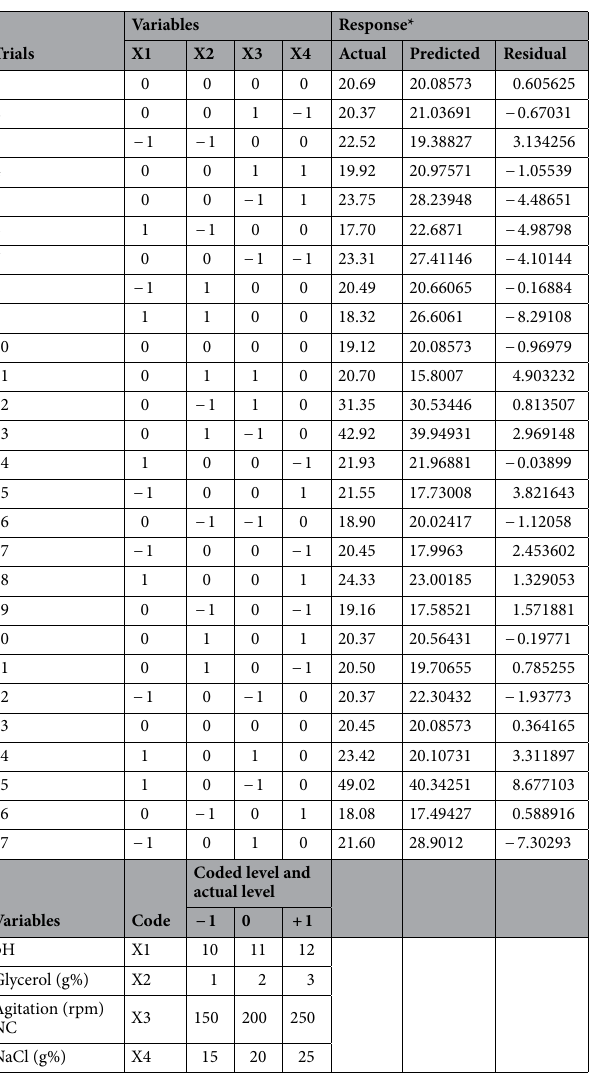
Table 4. BB factorial experimental design for biosurfactant production by Natrialba sp. M6. Triple tests were performed and the average of three reading was considered as the final. *Response is the reciprocal of the measured ST ×